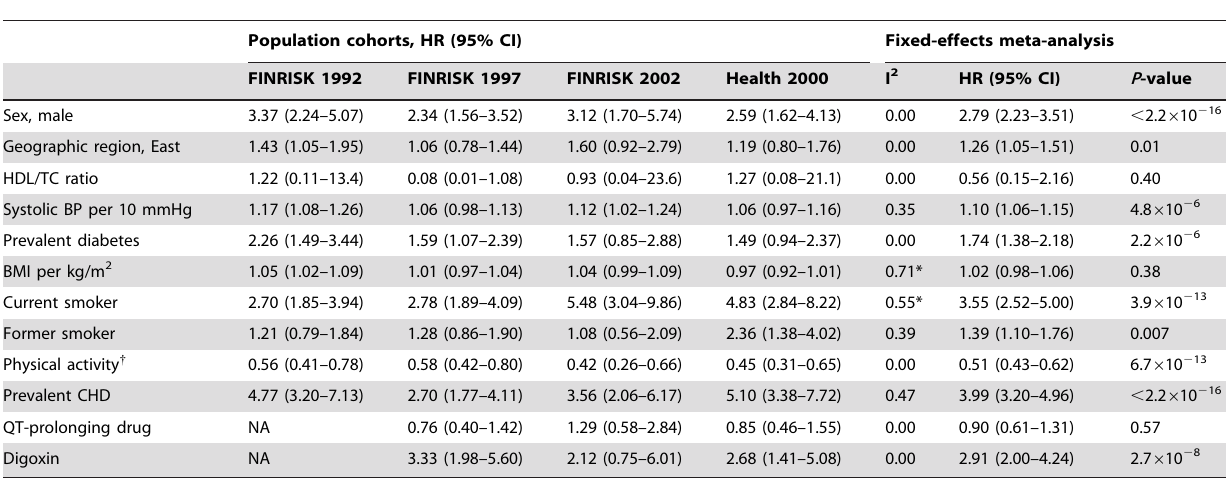
Table 2. Cardiovascular risk factors associated with SCD in a multivariate model in four population-based cohorts.